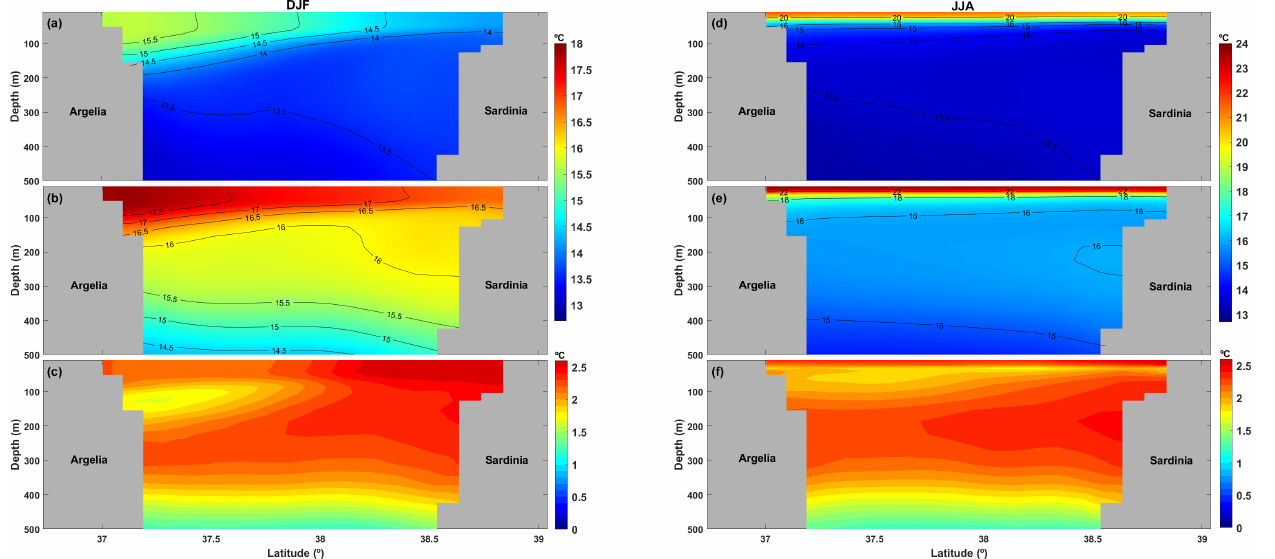
Figure 6. Winter (a–c) and summer (d–f) vertical cross sections of temperature, in ◦ C, through the Sardinia Strait for present (a, d) and future (b, e) climate as computed from ROM. Isotherms are also depicted. Differences between water temperature in the future and present climate are presented in panels (c) and (f) .